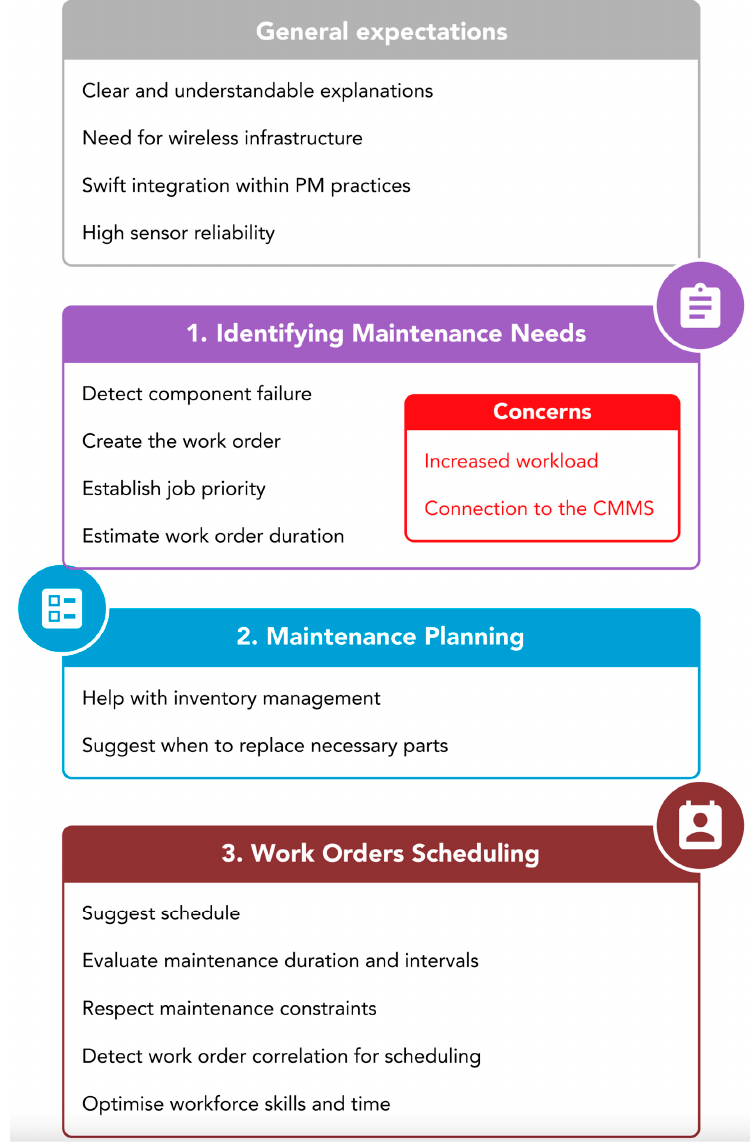
Figure 8. Predictive maintenance opportunities and